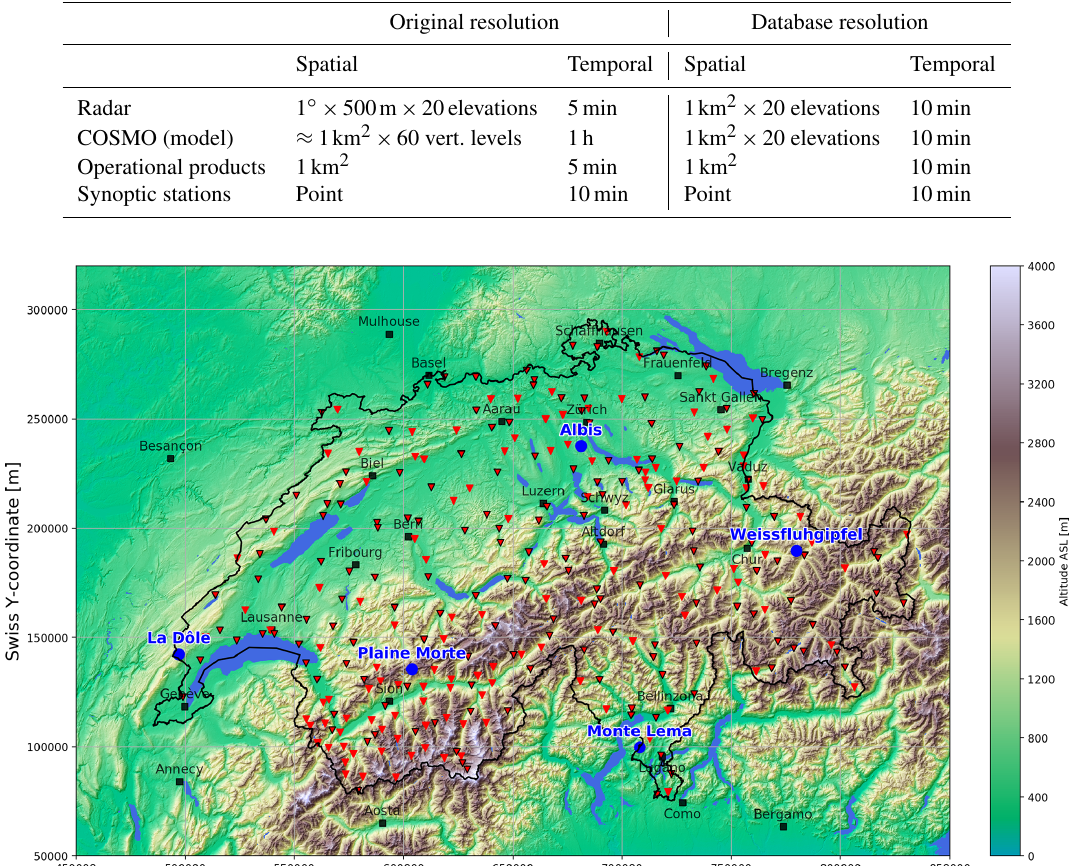
Figure 1. Topography of Switzerland with the five Swiss operational radars (blue circles), the 160 synoptic weather stations (red triangles with black border) and the 128 rain gauges (red triangles without borders). Major cities are indicated with black squares. This map is based on a digital elevation model provided by swisstopo.